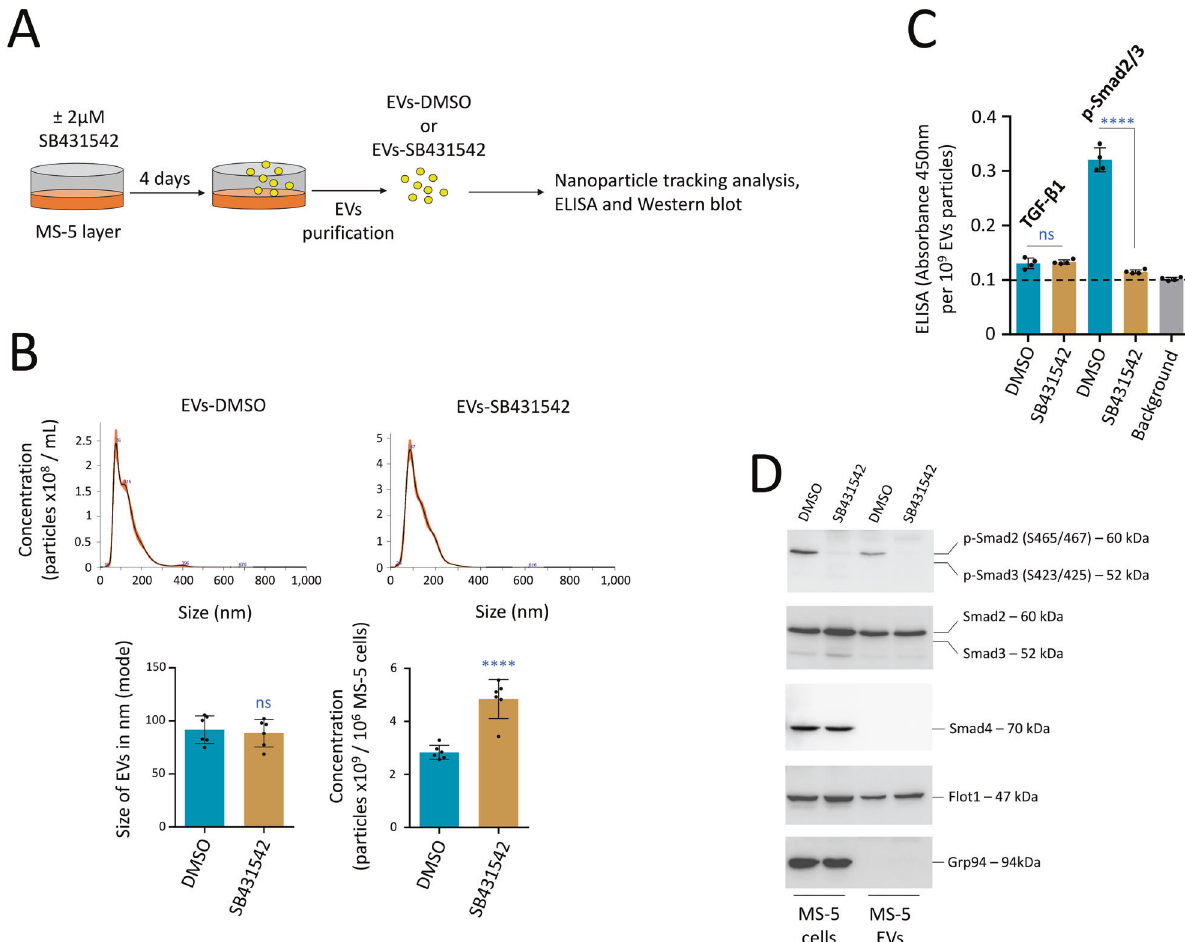
(ALK5) inhibitor (EVs-SB431542) or not treated (EVs-DMSO). Data are shown as means ± SD, n = 6 biological samples. C ELISA showing the presence of p-Smad2/3 in MS-5 EVs. Treatment with SB431542 abrogated the production of p-Smad2/3 in EVs. Low production of the active TGF- β 1 ligand in EVs was also detected by ELISA. Quanti fi cation was normalized to 10 9 particles, n = 4 biological samples. D Western blot showing the production of p-Smad2 in MS-5 cells and EVs. The co-Smad4 protein was only detected in MS-5 cells, not in EVs. MS-5 cells **** P < 0.0001; ns, non-signi fi